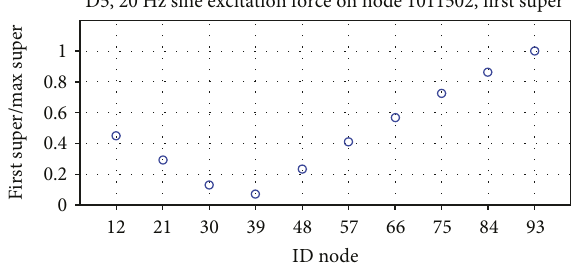
Figure 34: D5, 20 Hz excitation, normalized 1st